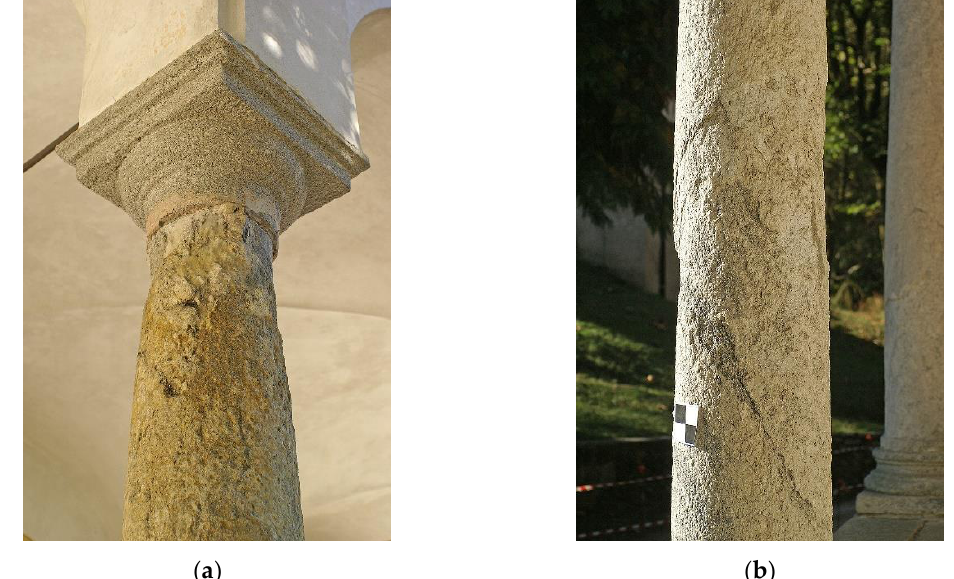
Figure 7. Different types of surface material degradation on the columns of the Via Crucis portico: ( a ) erosion; ( b ) exfoliation. Table 1. Values of dynamic modulus by ultrasonic tests on Via Crucis portico columns.